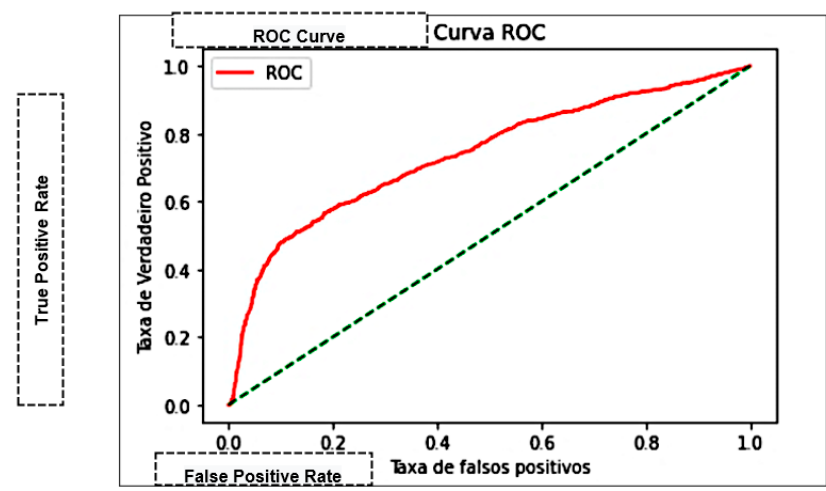
Figure 8. ROC curve—SVM.